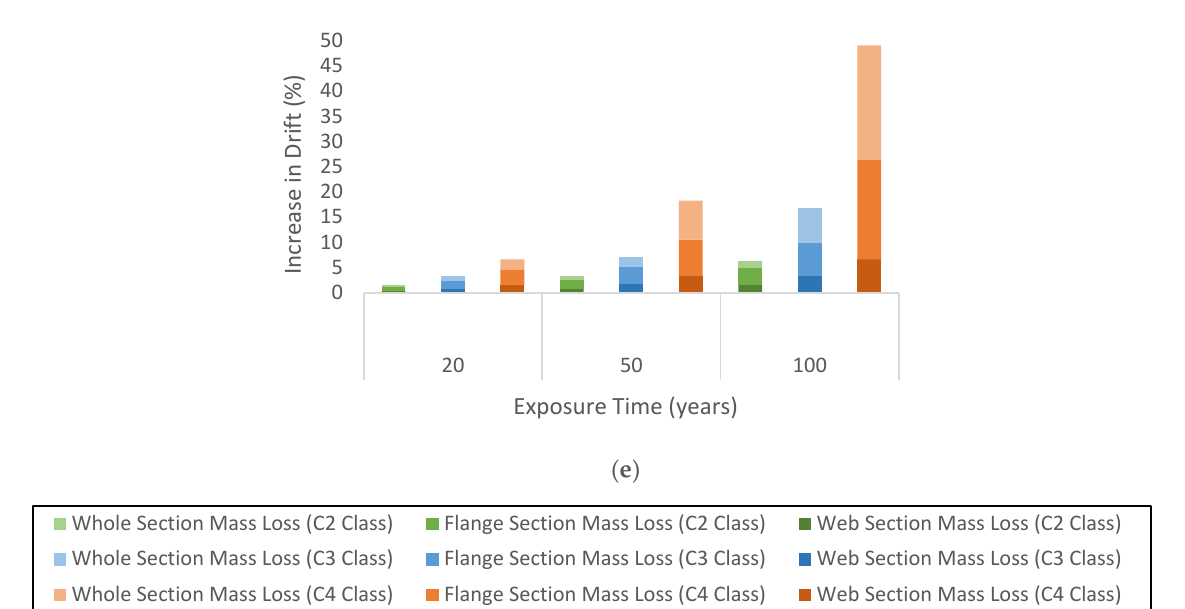
Figure 11. Comparison of drift ratio and mass loss for: ( a ) node A; ( b ) node B; ( c ) node C; ( d ) node D; ( e ) node E.